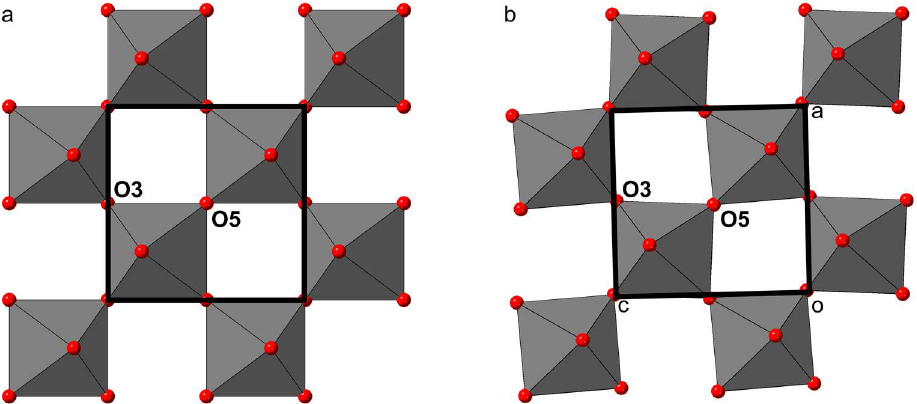
Figure 10. The arrangement of the octahedral layers in shulamitite ( a ) and sharyginite ( b ). Rotation of the octahedra is restricted by symmetry in shulamitite, as O3 and O5 reside on special positions. The lower symmetry of sharyginite allows the octahedra to rotate.